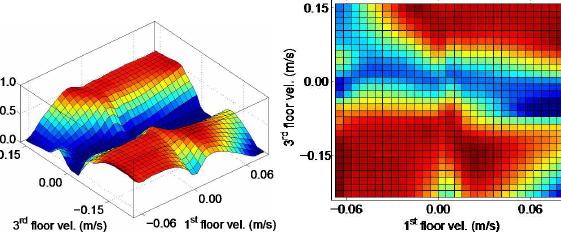
Figure 5: Uncontrolled response of the 3DOFs system.